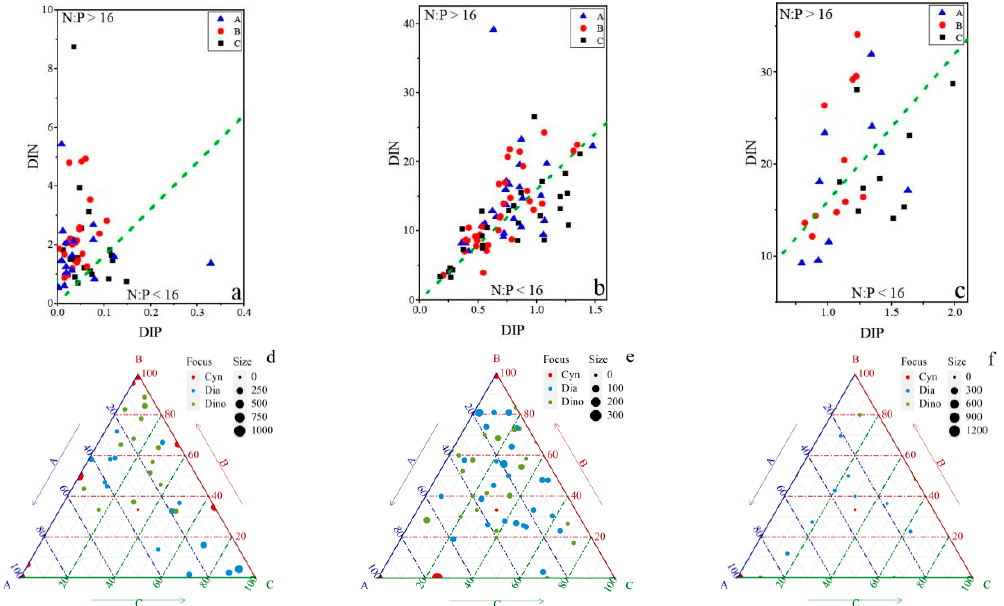
Figure 8. Distribution of phytoplankton (cells L − 1 ) and DIN and DIP ( µ mol L − 1 ) in different depths. ( a ) N:P in the surfer (5 m, 30 m), ( b ) N:P in the middle (75 m, 100 m, and 150 m), and ( c ) N:P in the bottom (300 m). ( d ) Distribution trends of phytoplankton (cells L − 1 ) in the surfer (5 m, 30 m). ( e ) Distribution trends of phytoplankton (cells L − 1 ) in the middle (75 m, 100 m, and 150 m). ( f ) Distribution trends of phytoplankton (cells L − 1 ) in the bottom (300 m). (Dissolved Inorganic Nitrogen: DIN;